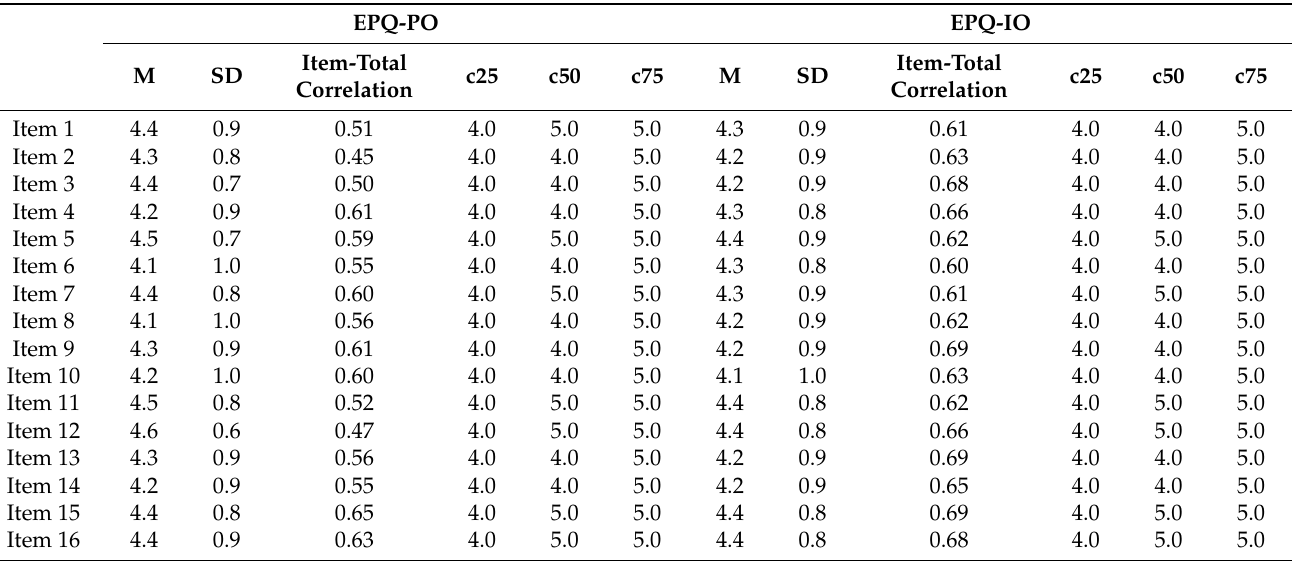
Table 2. Analysis by individual items of the EPQ